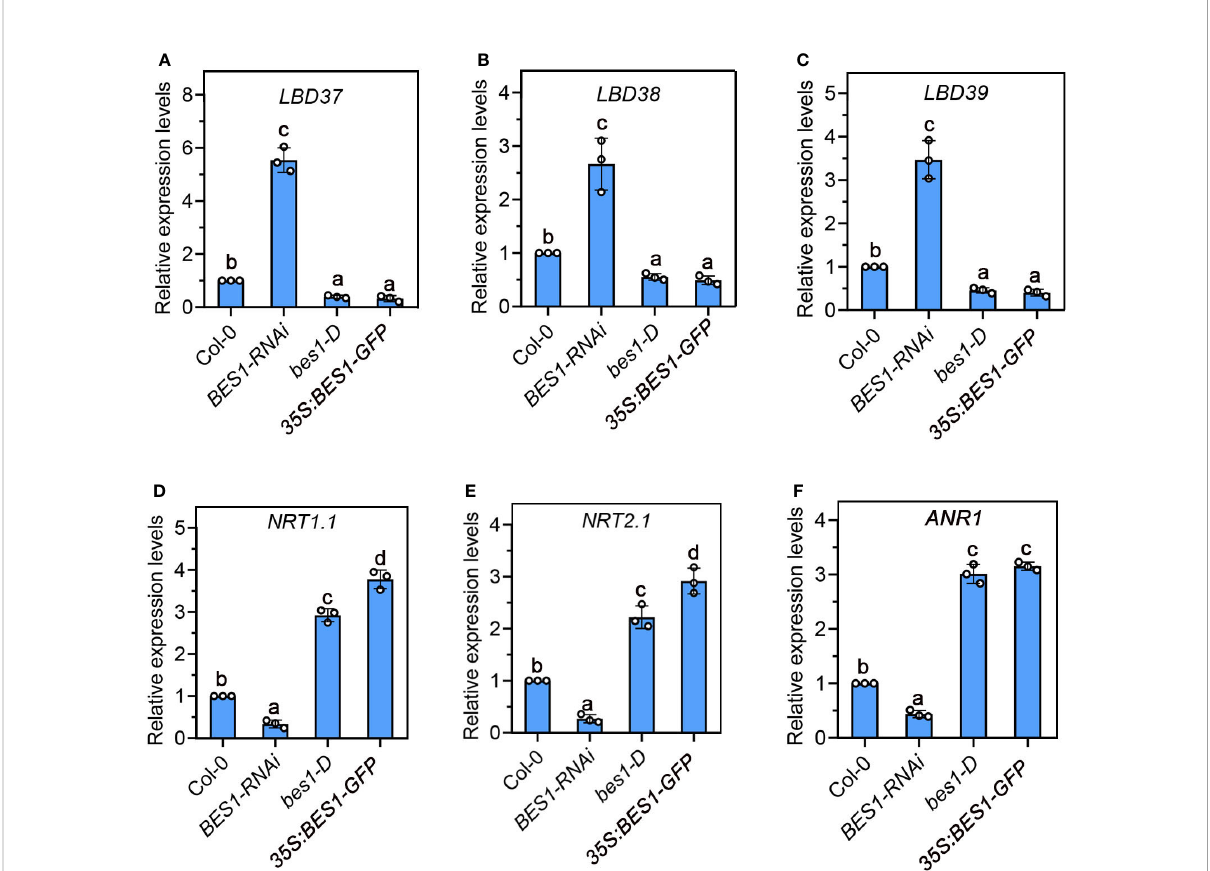
FIGURE 3 Expression of nitrate signaling repressors, LBD37/38/39 (A-C) , and LN-responsive genes NRT1.1 (D) , NRT2.1 (E) and ANR1 (F) in the roots of 7- day-old Col-0, BES1-RNAi , bes1-D and 35S:BES1-GFP at LN. The expression levels of genes in the Col-0 seedlings were set to 1.00. Error bars represent s.d. of three biological repeats. Different Lowercase letters above the bars indicate statistically signi fi cant differences between samples (p < 0.05, one-way